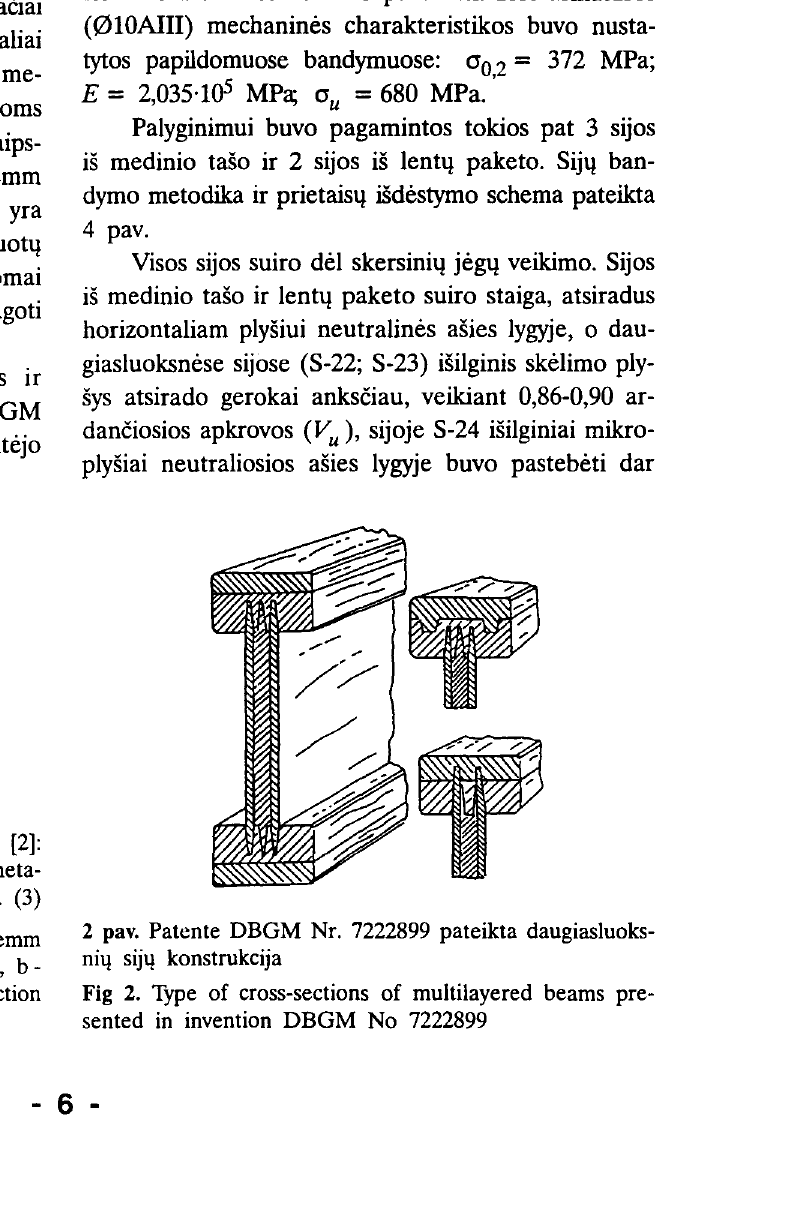
Fig 2. Type of cross-sections of multilayered beams